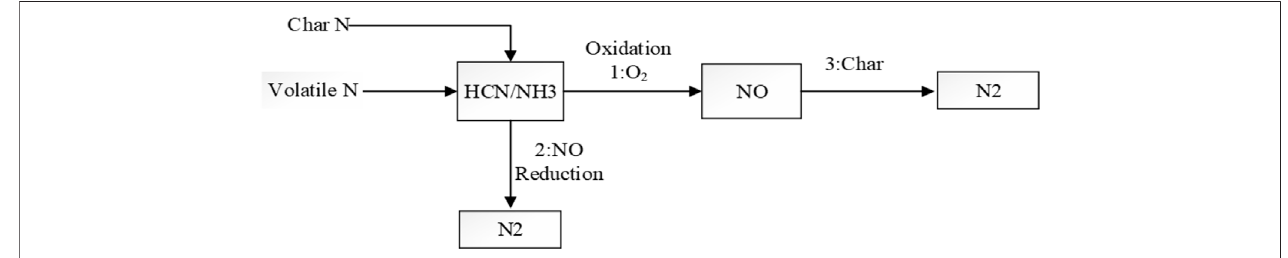
FIGURE 3 | Chemical reactions that lead to the formation of fuel NOx.